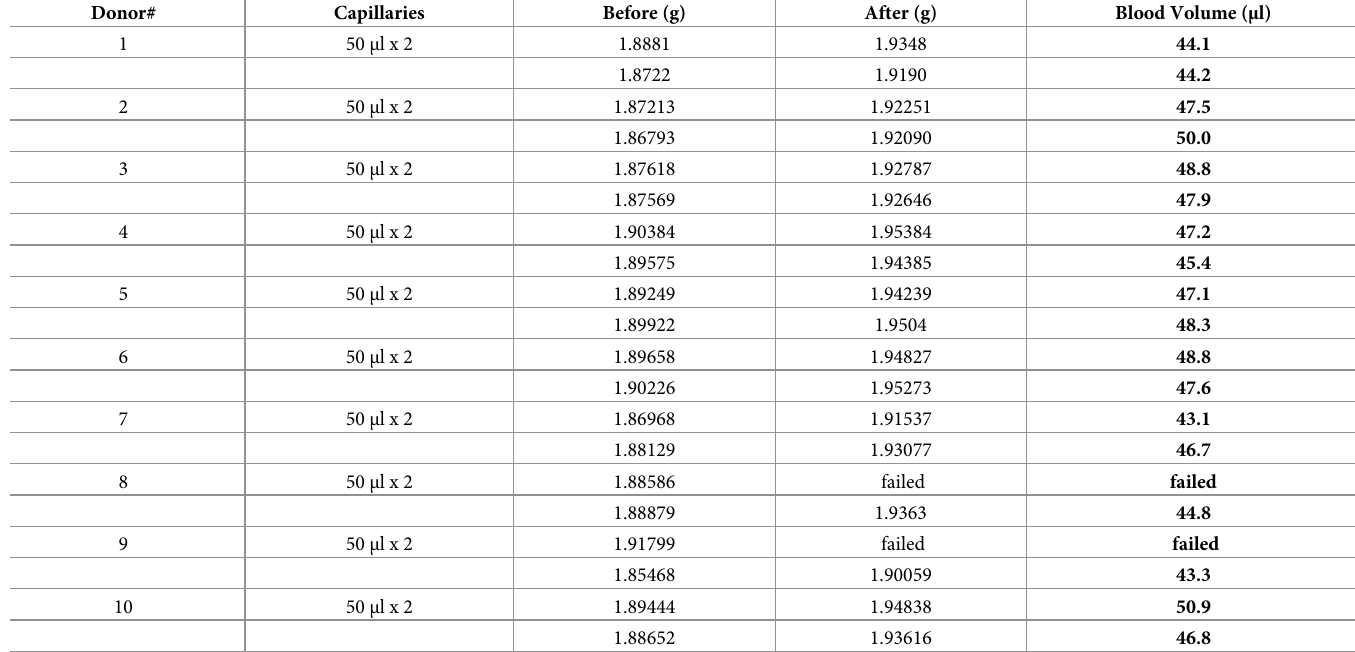
Table 2. Results of the integrated blood collector self-collection